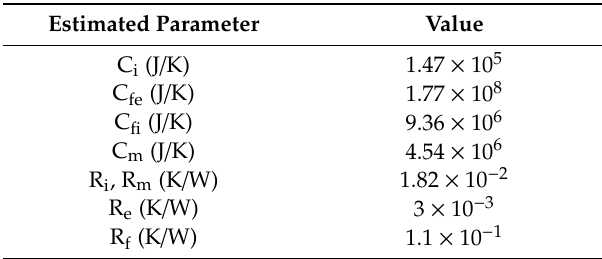
Table 1. Initial values for the estimated